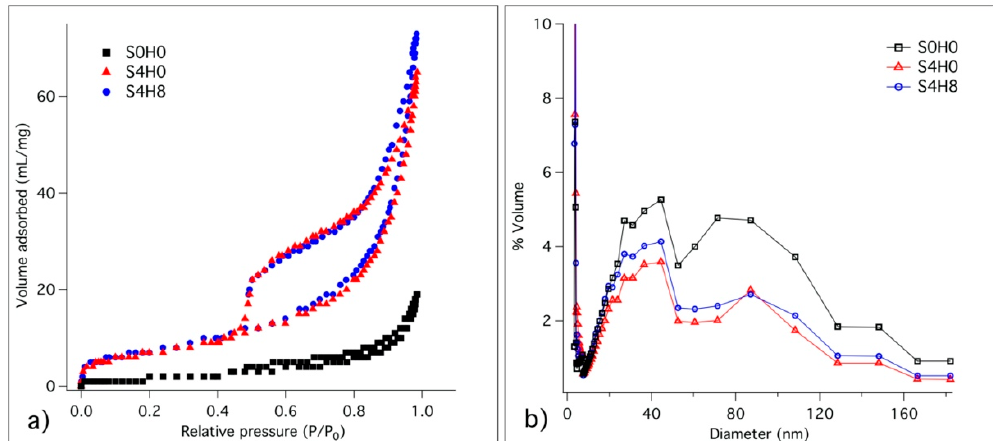
Figure 6. ( a ) Adsorption / desorption isotherms and ( b ) pore size distribution of S0H0, S4H0, S4H8 and S8H8. Samples have been lyophilized and analysed after 28 days of hydration. Table 2. BET surface area and total pore volume of S0H0, S4H0 and S4H8 samples. Sample BET Surface Area (m 2 /